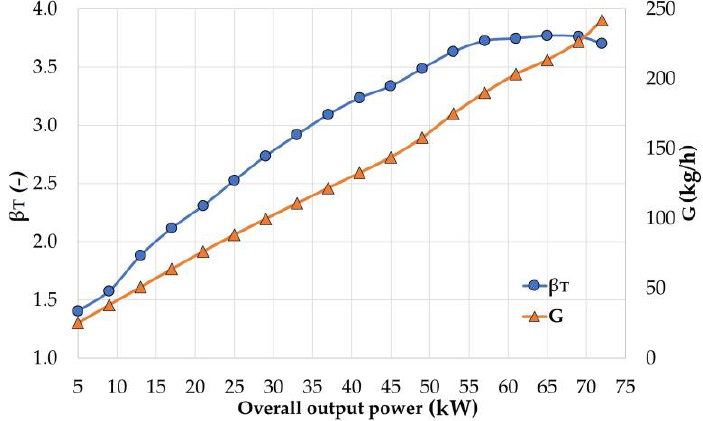
Figure 4. Turbine operating conditions (mass flow rate G and pressure ratio β T ) related to the best efficiency curve of the preliminary compound engine [2].